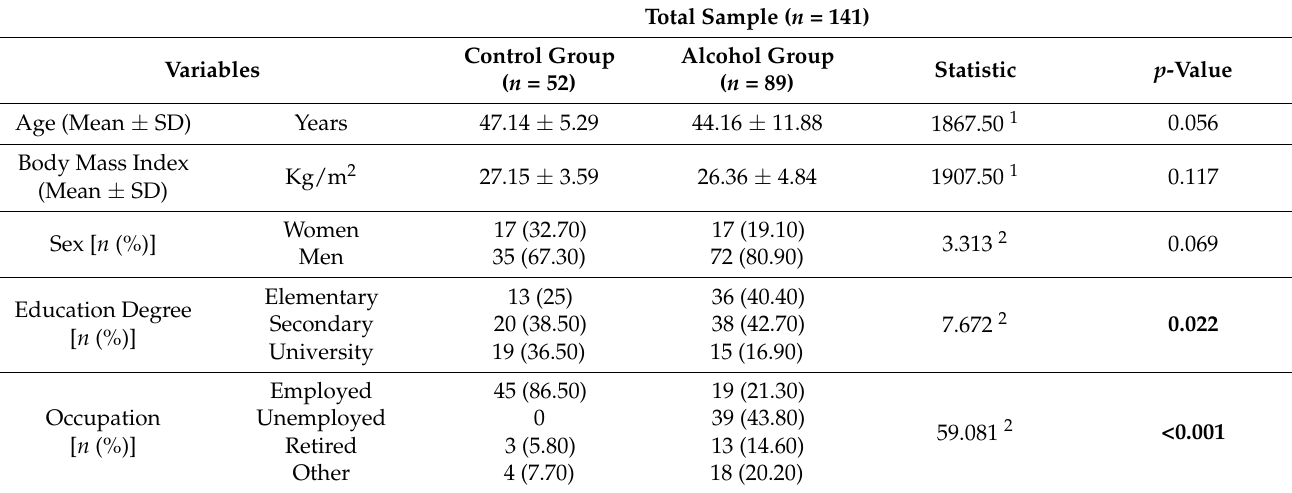
Table 1. Socio-demographic characteristics of the total sample.